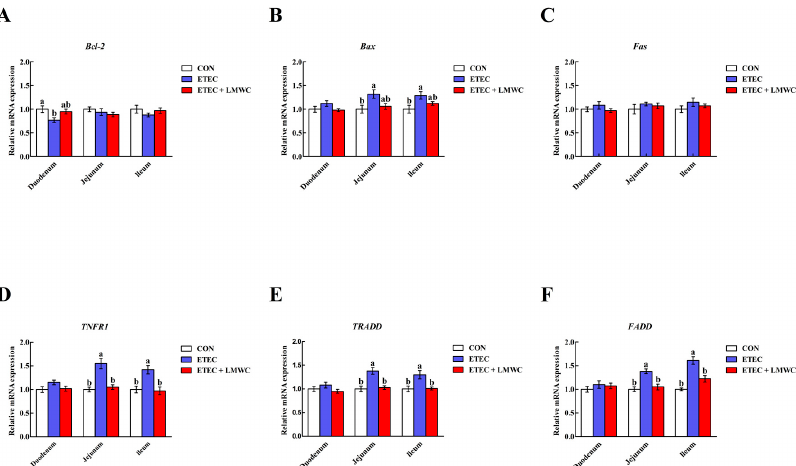
Figure 9. Effects of low-molecular-weight chitosan on the mRNA levels of Bcl-2 ( A ), Bax ( B ), Fas ( C ), TNFR1 ( D ), TRADD ( E ) and FADD ( F ) in the small intestine of weaned pigs challenged with enterotoxigenic Escherichia coli . ( A ) Bcl-2 , B-cell lymphoma-2. ( B ) Bax , B-cell lymphoma-2-associated X protein. ( C ) Fas